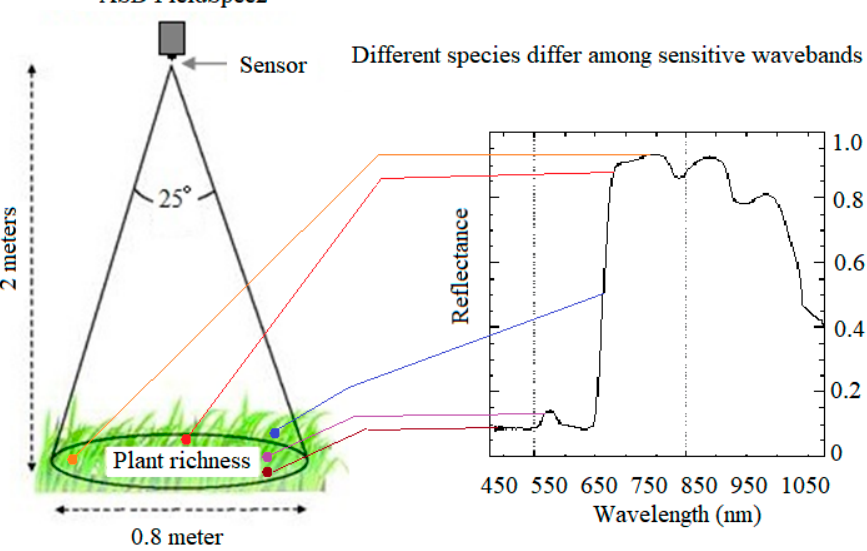
Figure 2. Illustration of the field measurement of spectral reflectance using the ASD. Numerous spectral indices at plot scale are extracted from the received signals of the ASD sensor representing the specific spectral reflectance patterns of the different species (reference from [29])